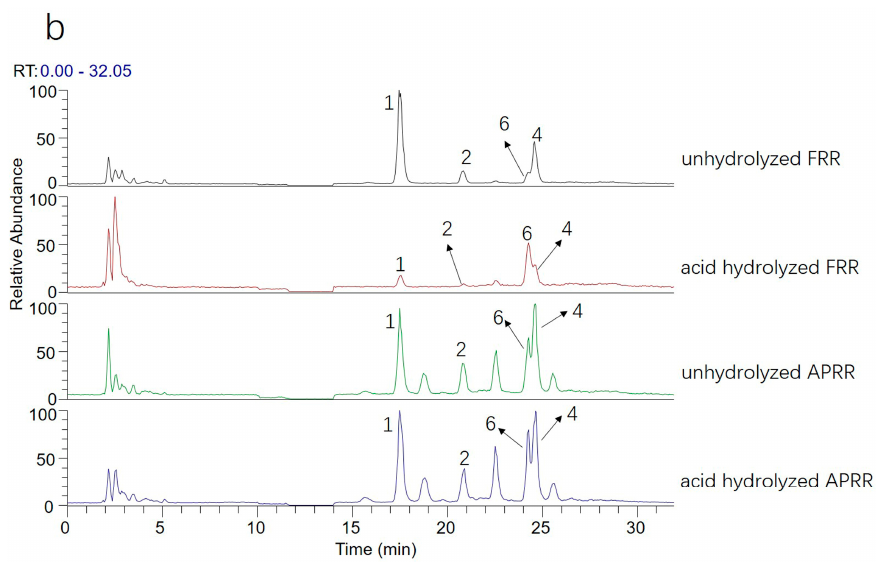
Figure 9. Total ion chromatograms (TICs) of ( a ) acid hydrolyzed products in standard saccharide and ( b ) acid hydrolyzed products and unhydrolyzed products of FRR and APRR in positive ion mode using UHPLC-LTQ-Orbitrap-MS. (1. manninotriose, 2. melibiose, 3. raffinose, 4. glucose, 5. stachyose, 6. galactose).